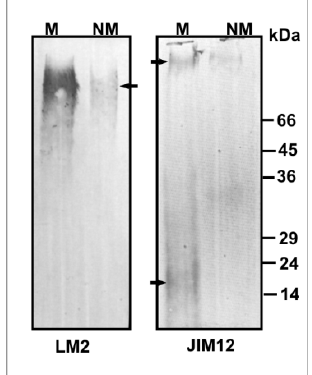
Figure 4. Immunoblot analysis of arabinogalactan protein (Lm2) and extensin (Jim12) antigens in extracts of metallicolous (M) and non-metallicolous (NM) Anthyllis leaves. Aliquot containing 20 µg of proteins was loaded per lane. The position of the molecular weight marker is indicated.